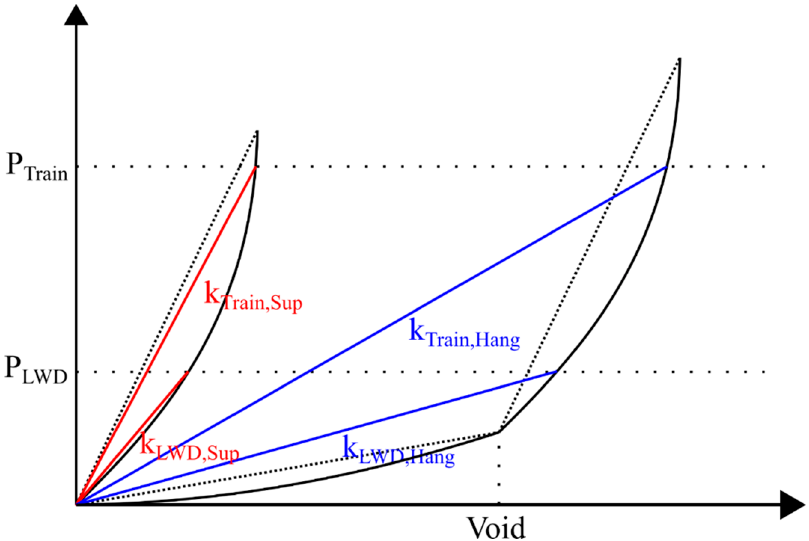
Figure 3. Load–deflection characteristics of ballasted track [15].